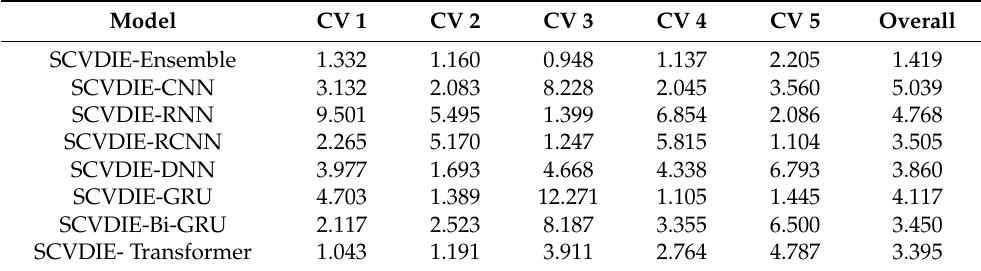
Table 5. Error assessment